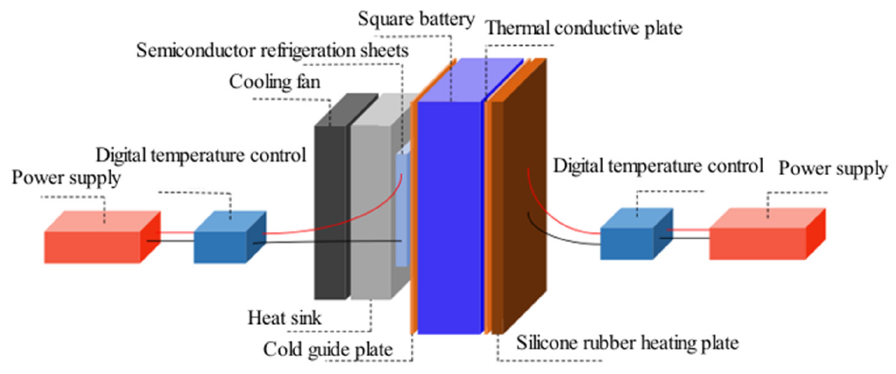
Figure 1. Block diagram of battery module with forced thermal gradient.